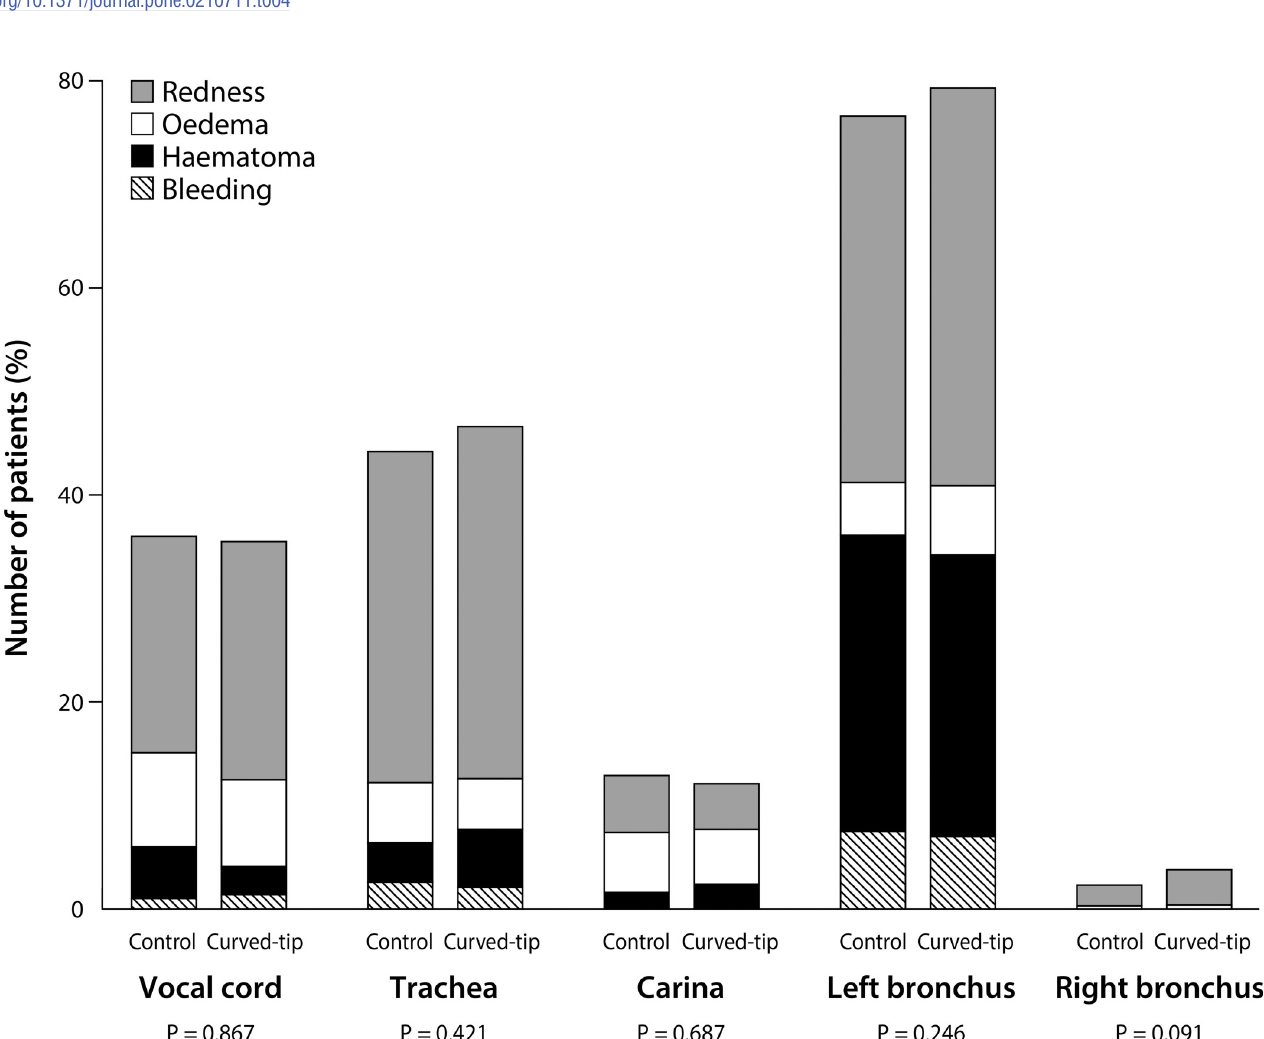
Fig 4. The site and type of postoperative airway injury. P values were obtained by comparing the incidence of airway injury between groups using Fisher’s exact